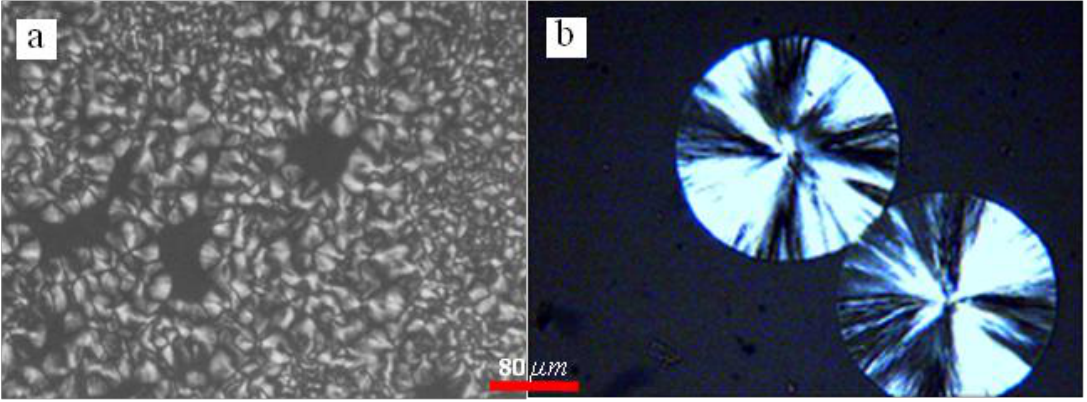
Figure 10. POM of PLLA crystallized isothermally at ( a ) 110 °C for 16 min and ( b ) 140 °C for 30 min, respectively.